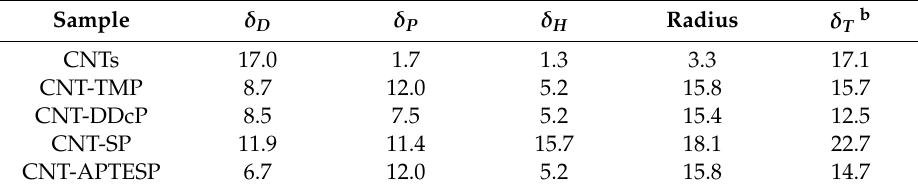
Table 4. Hansen solubility parameters (HSP) and sphere radius for the CNT-PyC adducts a . Sample